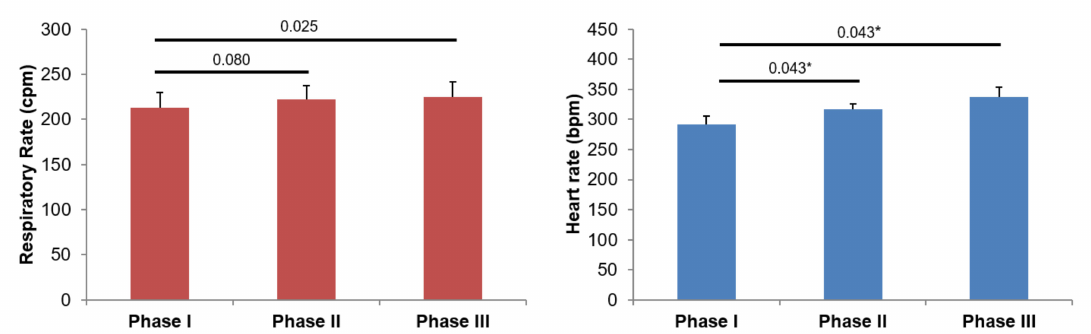
Figure 3. Mean + standard deviation of the heart rate (left) and respiratory rate (right) for the three phases of the protocol (Phase I—baseline; Phase II—atenolol dose #1; Phase III—atenolol dose #2). Statistical comparisons ( p -values) versus baseline are shown (* p <